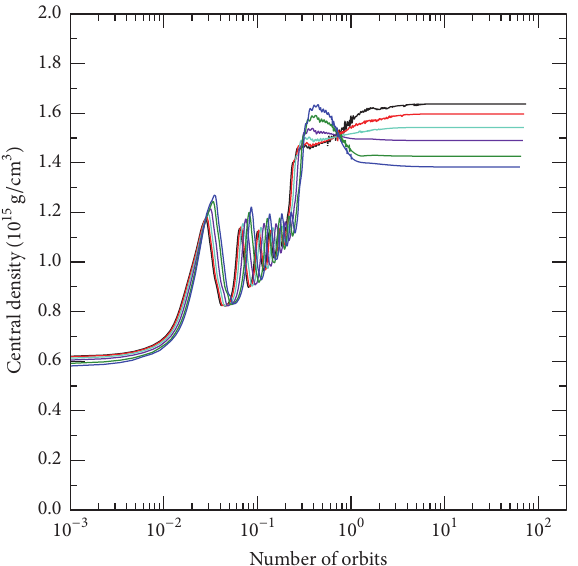
Figure10:Computedgravitationalwavefrequency, 𝑓 ,versusproper separation for each EoS as labelled. The black line corresponds to the (post) 5/2 -Newtonian estimate. Frequencies obtained from the stiff and polytropic equations of state do not deviate by more than ∼ 10% from the PN prediction until a frequency greater than ∼ 300 Hz. The grey line is an extrapolation of the frequencies obtained using the soft MW and GLN EoSs. These begin to deviate by more than 10% from the PN prediction at a frequency of ∼